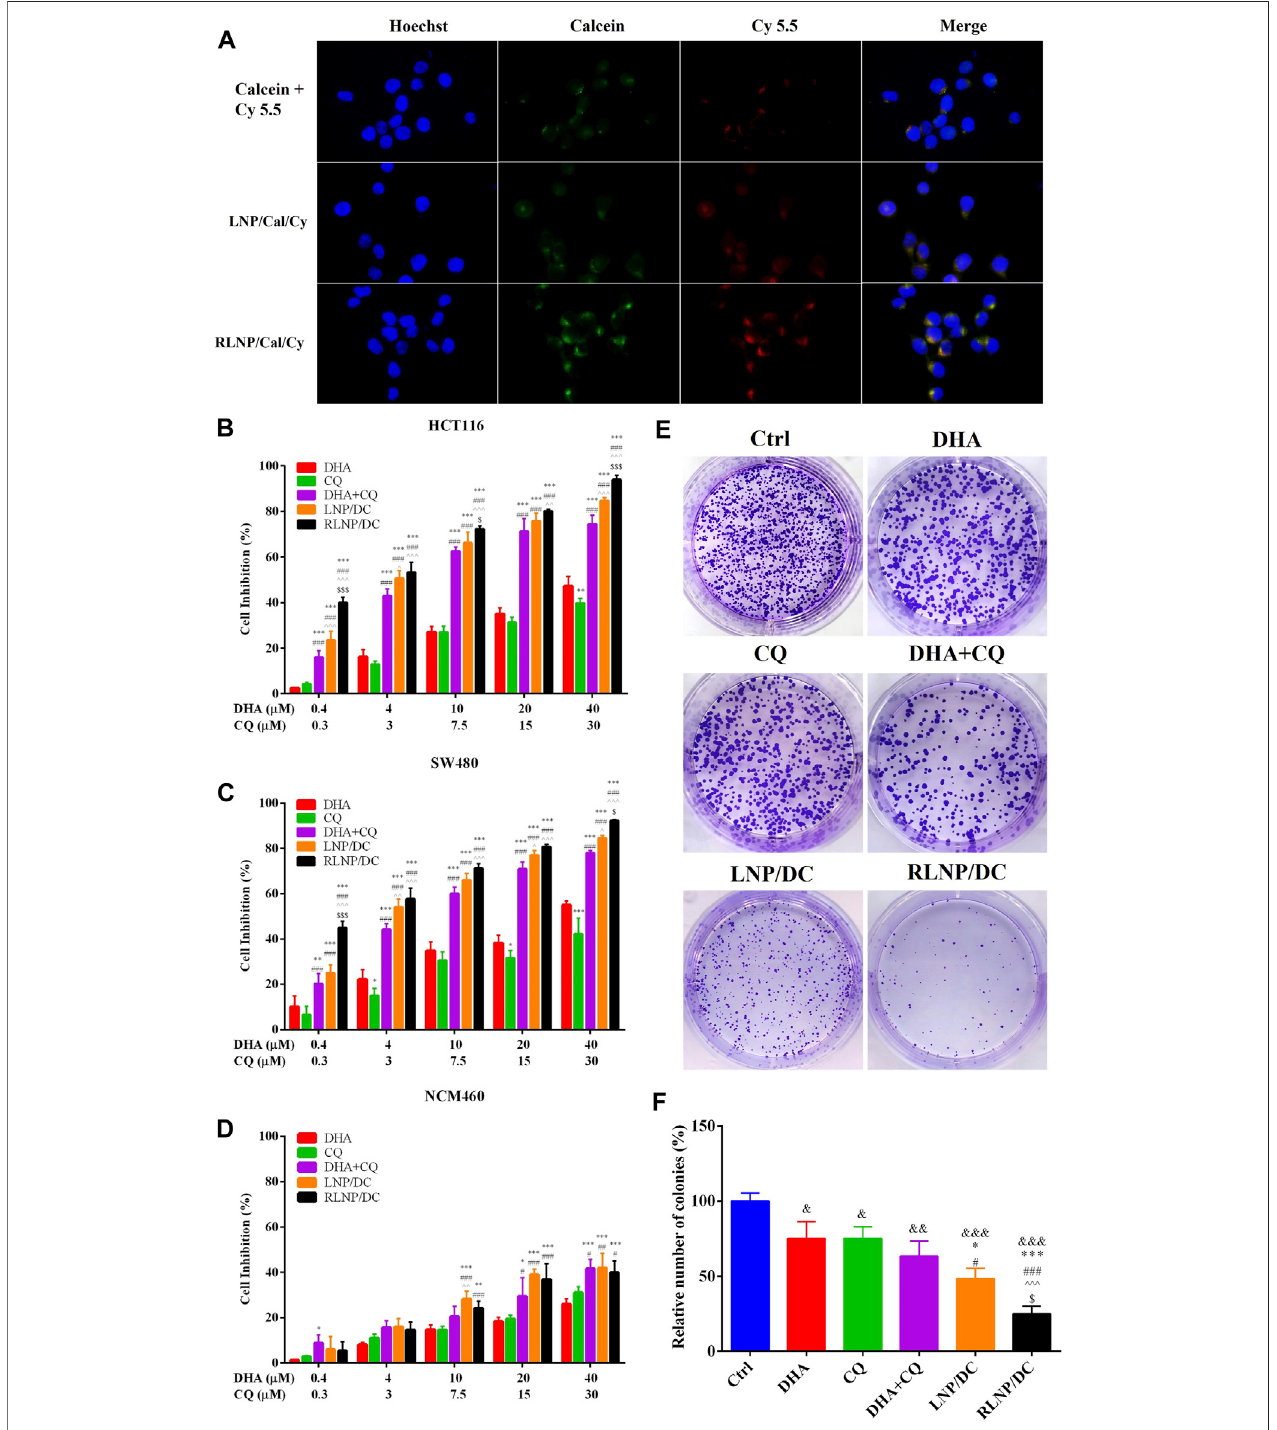
FIGURE3| EvaluationofcytotoxiceffectandcellularuptakeofLNPs. (A) CellularuptakeofcalceinandCy5.5-labeledLNPsbyHCT116colorectaltumorcellsafter 4 h of treatment (Scar bar reads 20 µm). (B , D) Cytotoxicity of DHA, CQ, DHA + CQ, LNP/DC, and RLNP/DC on HCT116 cells (B) , SW480 cells (C) and NCM460 cells (D) . (E, F) Colony formation assayvia observation (E) and quanti fi cation (F) bymicroscopy.Each bar representsthemean ± SD ( n ≥ 3). * p < 0.05, & p < 0.05, && p < 0.01, and &&& p < 0.001 vs. Ctrl; ** p < 0.01 and *** p < 0.001 vs. DHA; # p < 0.05 and ### p < 0.001 vs. CQ; ^ p < 0.05, ^^^ p < 0.01, and ^^^^ p < 0.001 vs. DHA + CQ; $ p < 0.05 and $$$ p < 0.001 vs. LNP/DC.